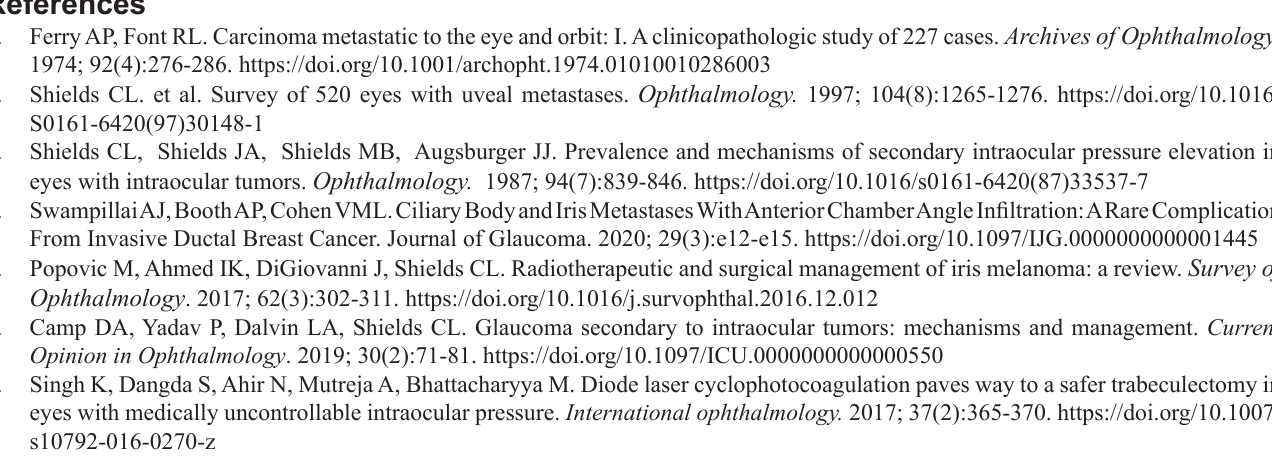
tomography: condition after right thoracotomy, removal of a mass S 3 of the upper lobe of the right lung (2016). On computer tomography shown lymphoadenopathy of mediastinal, right supraclavicular lymph nodes. Ultrasound of peripheral lymph nodes: lymphoadenopathy of cervical, supraclavicular, axillary, and inguinal lymph nodes. Biopsy of supraclavicular lymph node on the right: the morphological picture corresponds to the metastasis of solid carcinoma to lymph